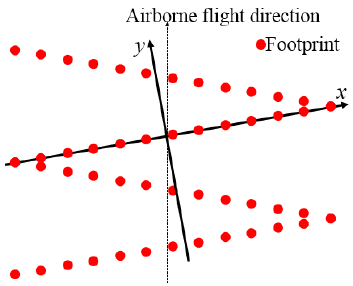
Figure 5. x - y coordinates for small